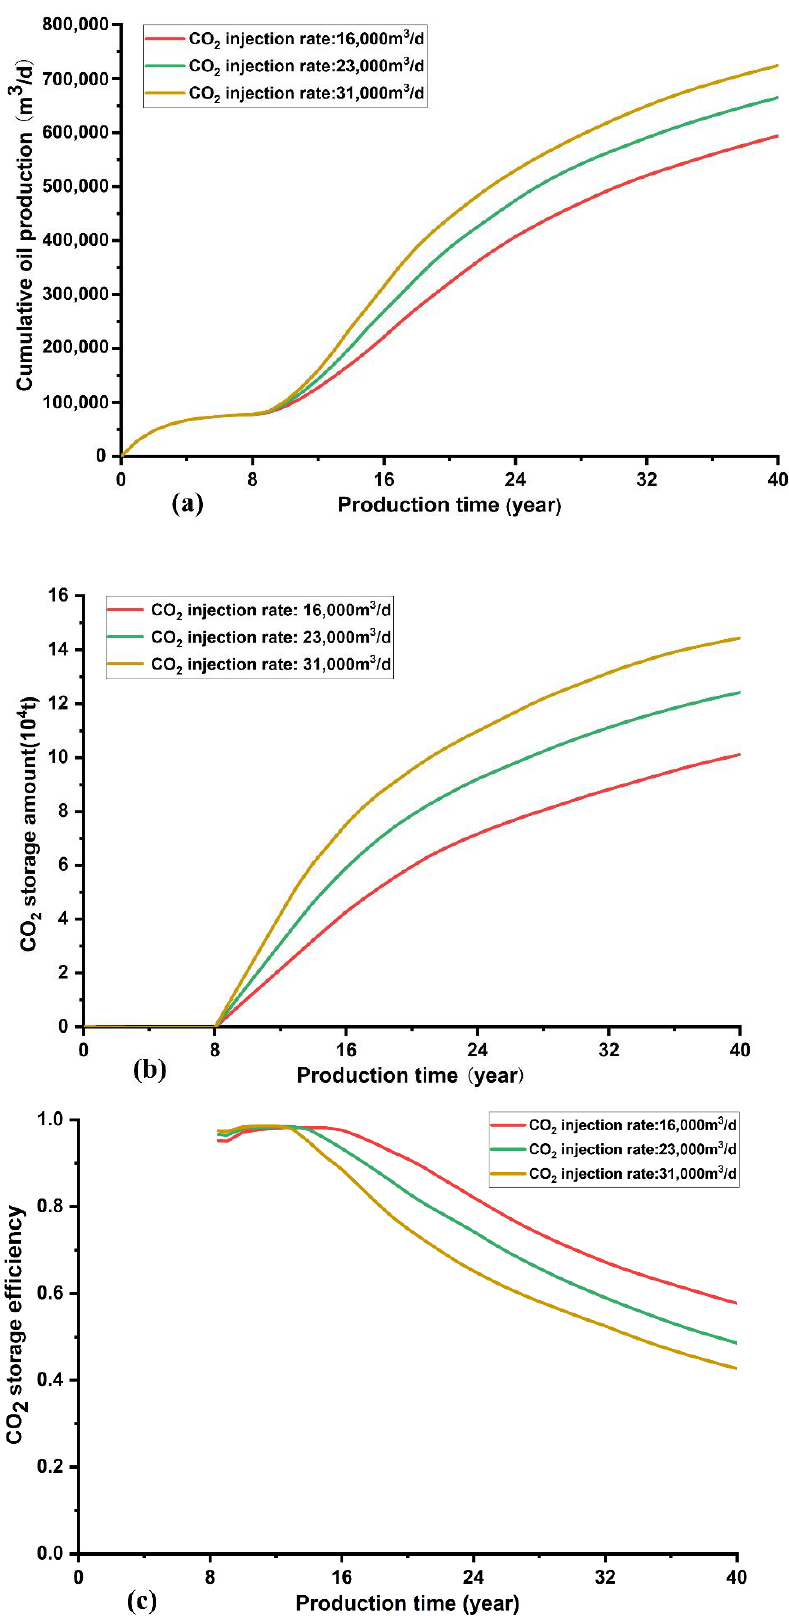
Figure 10. Effect of fluid injection rate on ( a ) cumulative oil production, ( b ) CO 2 storage amount, and ( c ) CO 2 storage efficiency.